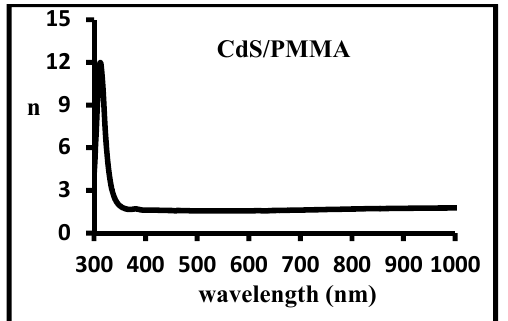
Fig. 6: The variation of the refractive index as a function of the wavelength for CdS/PMMA thin film.